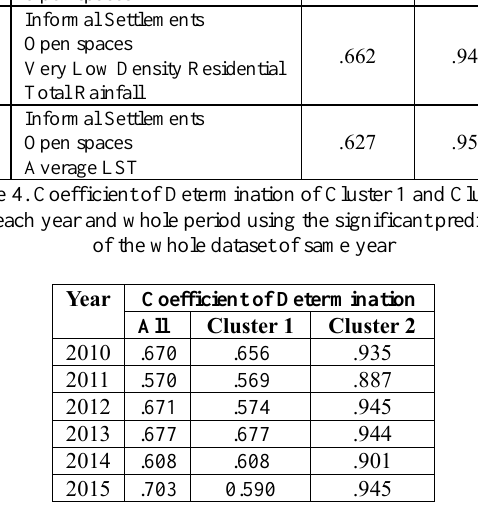
Table 5. Coefficient of Determination of Cluster 1 and Cluster 2 for each year and whole period using the significant predictors of 2010 – 2015 whole dataset